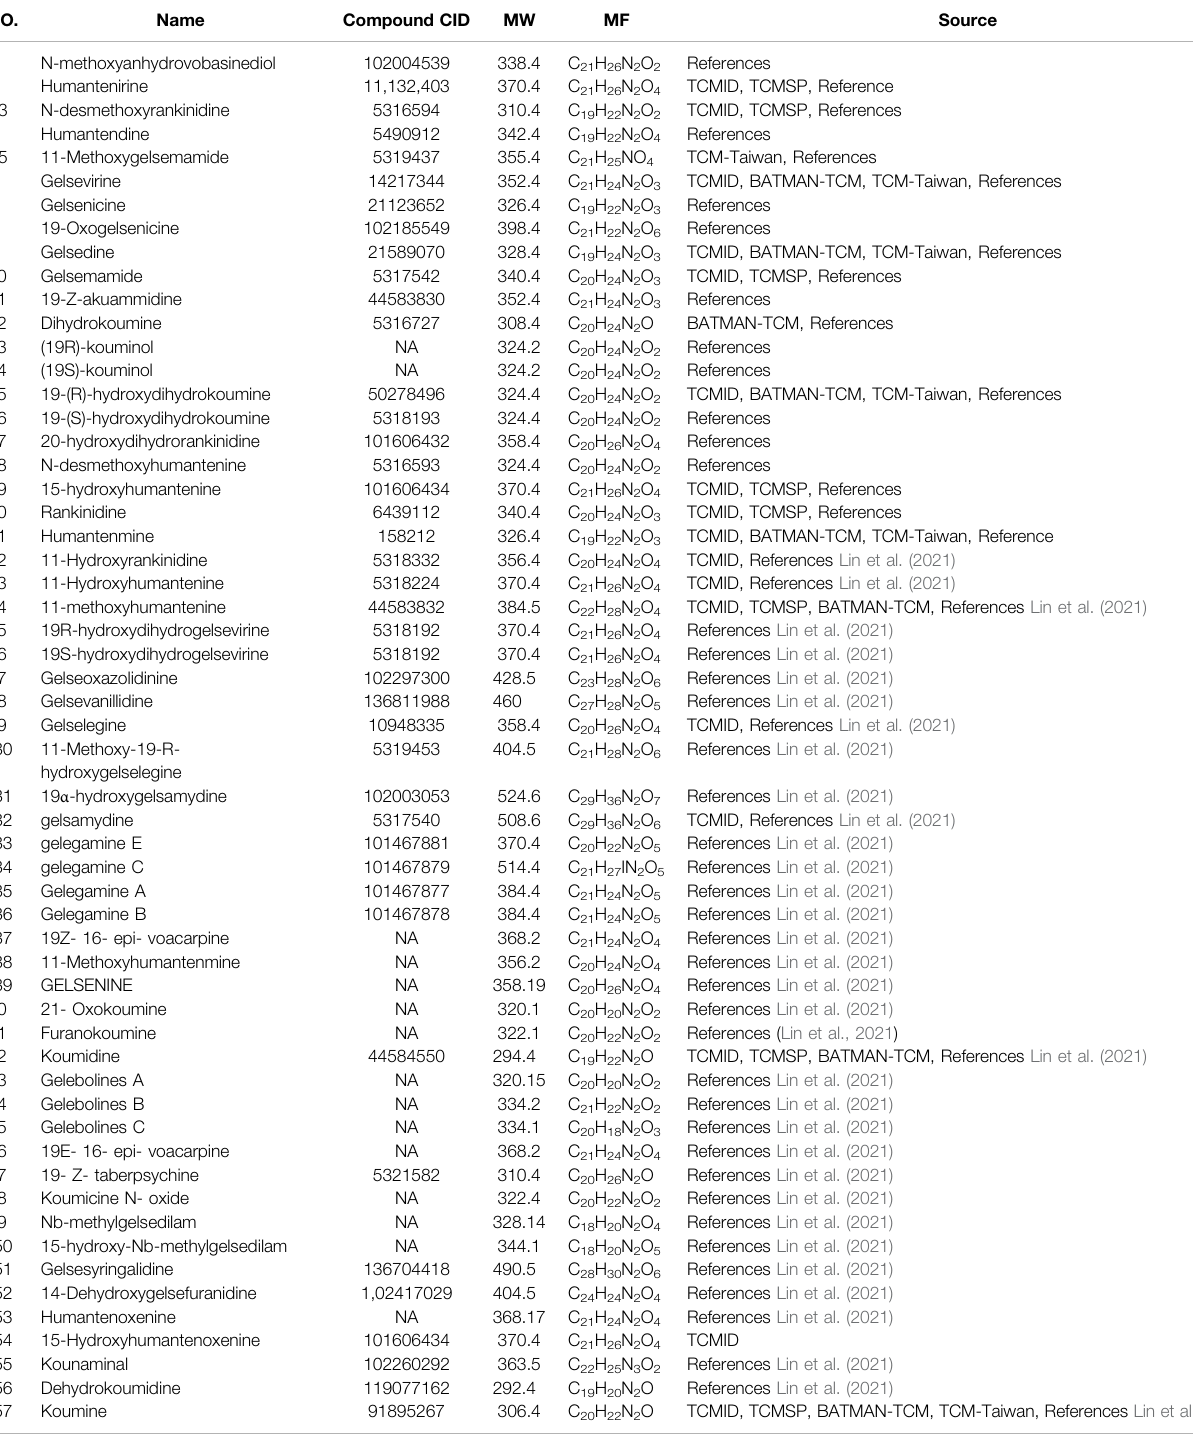
TABLE 1 | Information of the active compounds in GEB for network analysis.